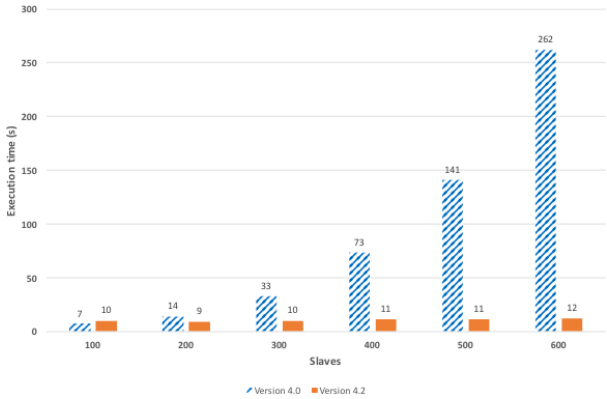
Figure 18. Execution time of the input phase at UNA for 24h fore- casting over the 20km grid.